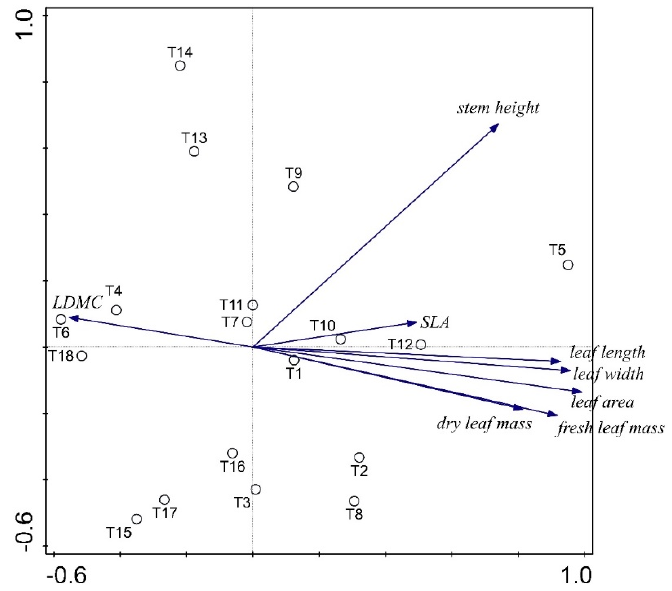
Figure 3. Ordination biplot of the first two axes of PCA analysis (1st axis horizontal, 2nd axis vertical). Distance measure is the square of the Jaccard similarity index. The arrows indicate measured life traits (SLA-specific leaf area, LDMC-leaf dry matter content), and the circles indicate sampled population (labels correspond to those in Table 1).